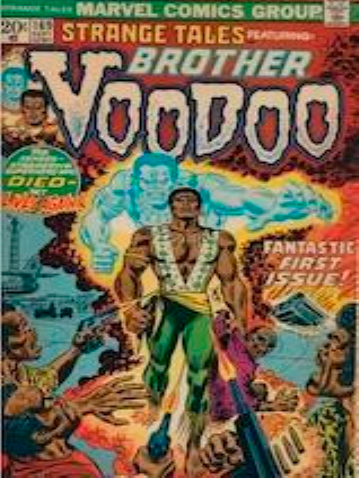
Figure 11. First cover appearance of Brother Voodoo , 1973.